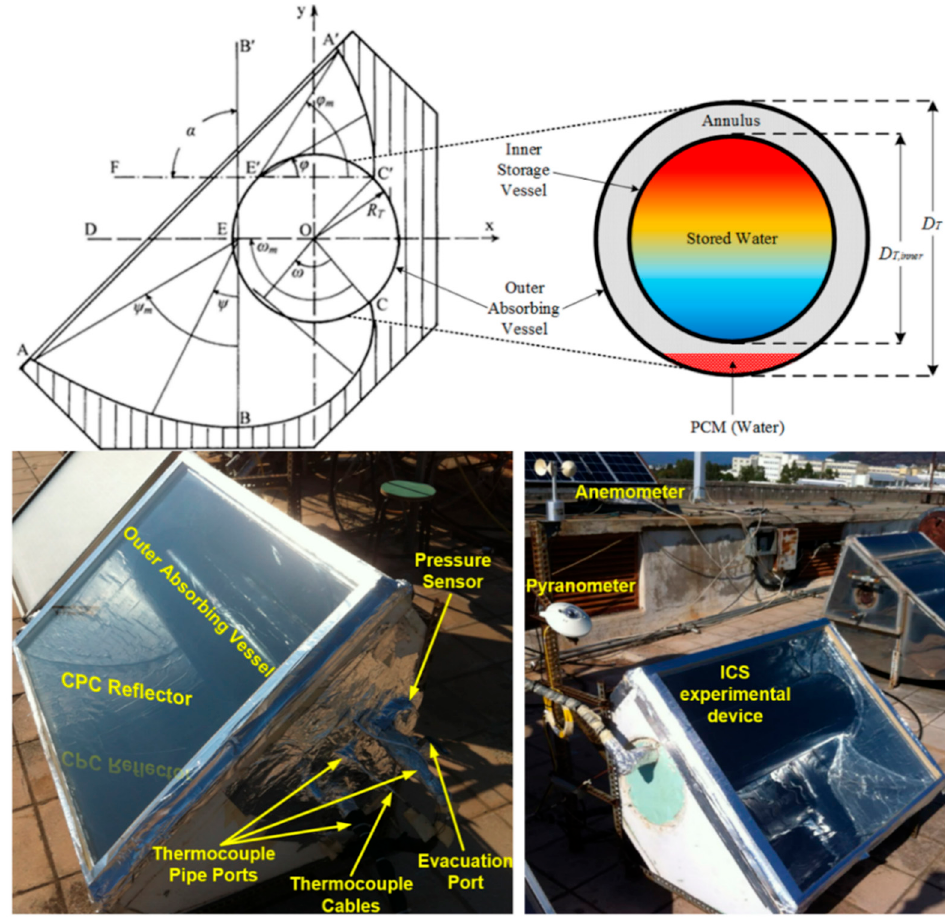
Figure 1. ICS water heater with asymmetric reflector and double wall tank [26,27].